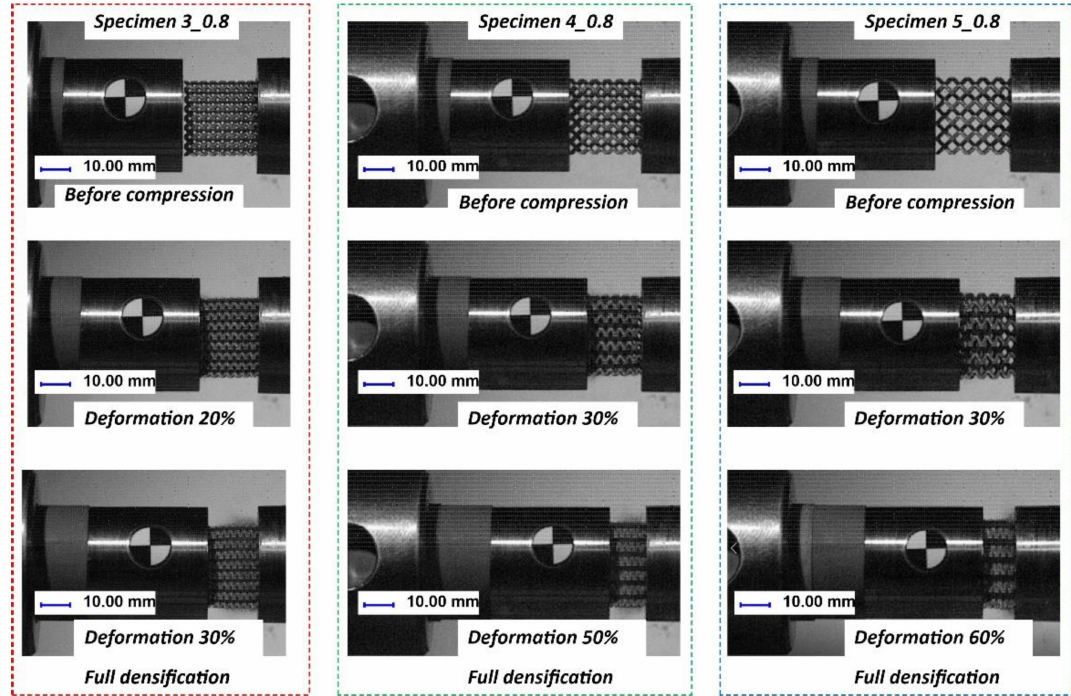
Figure 22. Example views of the deformation processes of lattice structures with di ff erent unit cell size values under impact loading conditions.